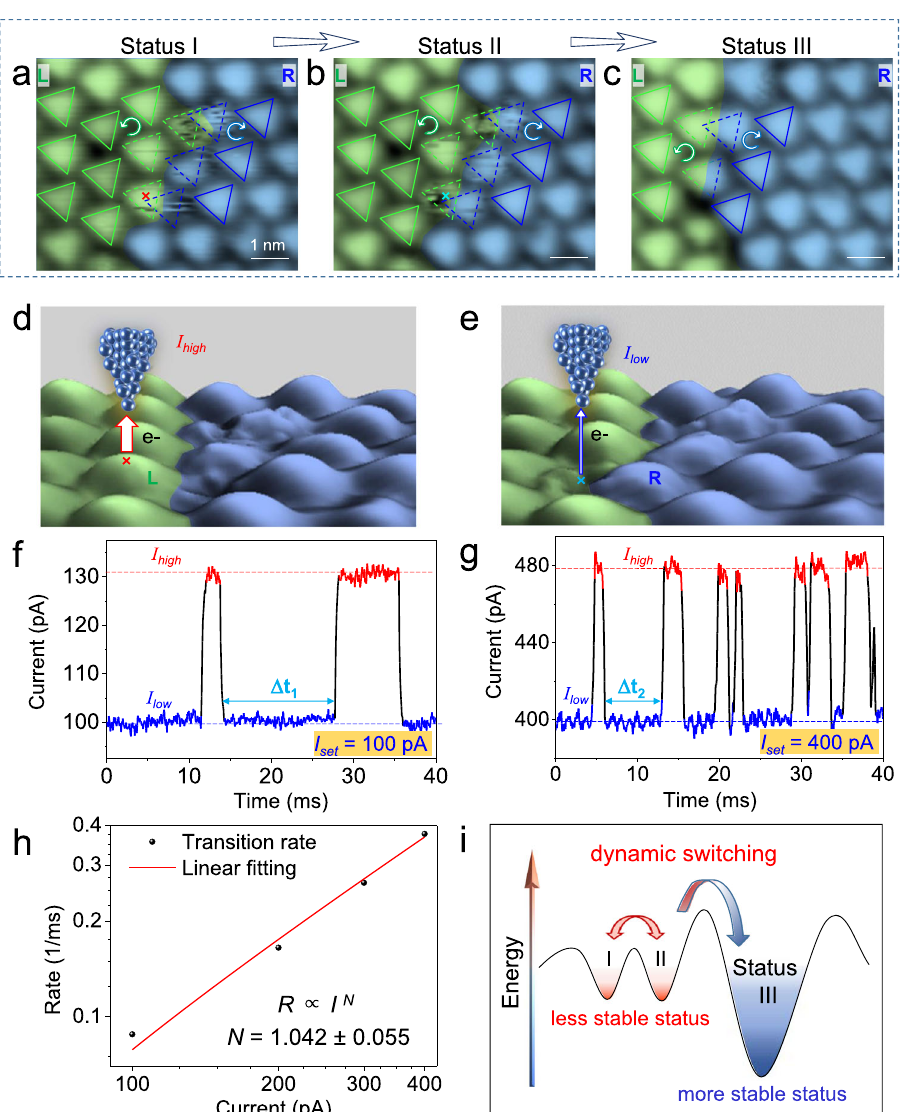
Fig. 3 Dynamic process of the chirality switching in the CDW superlattice. a , b STM topography of the same area in a 1T-NbSe 2 island, showing the fast switching between transition states I and II around the chiral DB. Green and blue triangular lattices are superimposed on the STM images and indicate the L and R domains, as well as the con fi guration at the chiral DB. The dashed SODs refer to the CDW sites, which are fuzzy due to the fast switching between two chiral domains. c State III showing the same area as in ( a ) and ( b ) with the stabilized chiral DB. d , e Schematic of the STM tip above the SOD at the fuzzy chiral DB (3D views of a and b ) to monitor the chiral change, which results in high and low tunneling currents ( I high and I low ), respectively. f , g Time − current ( I − t ) curve recorded with gaps of − 1.5 V, 100 pA before turning off the FB loop and − 1.5 V, 400 pA, respectively. The switching rate of the fuzzy chiral SOD is tuned by the tunneling current. h Switching rate ( R ) as a function of the tunneling current ( I ) plotted in the log scale. The linear line represents the power-law fi t ( R ∝ I N ) with N = 1.042 ± 0.055 indicating a one-electron process. i Schematic of chiral CDW changes induced by energy.